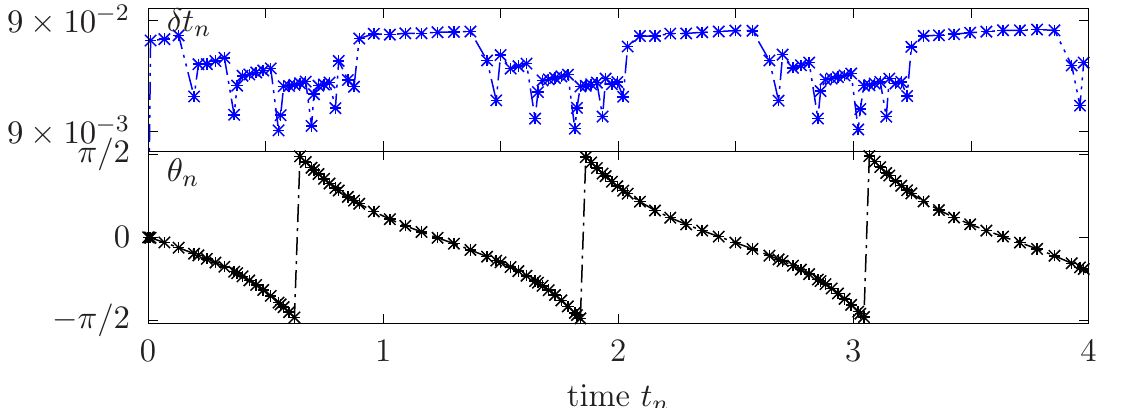
Figure 8. Flowing vesicle under TB regime: Adapted time steps δ t n and inclination angle θ n for a vesicle in a tumbling regime.